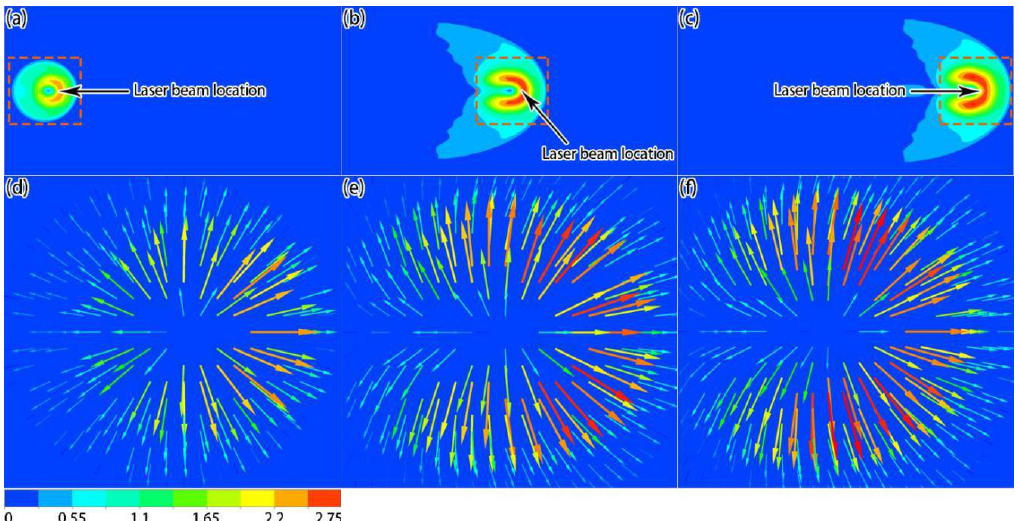
Figure 7. Simulation results of velocity magnitude ( a – c ) and local velocity ( d – f ) distributions on the surface at di ff erent times: ( a , d ) 6 × 10 − 5 s; ( b , e ) 4.5 × 10 − 4 s; ( c , f ) 8.4 × 10 − 4 s (unit: m /